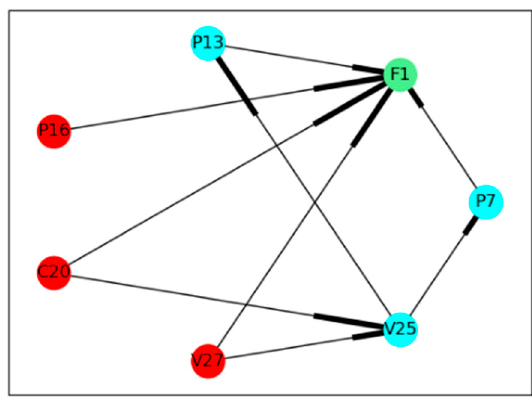
Figure 11. Fault propagation digraph in fault 1.